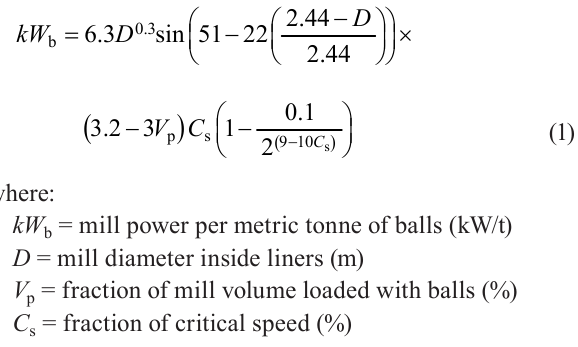
Table 2 True and bulk densities of tested